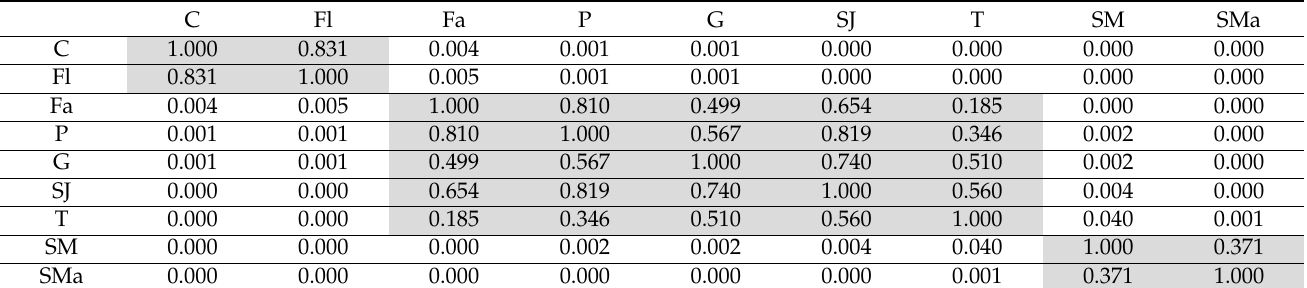
Table 5. Correlation matrix of the ISAR model with a Gaussian process for the Canary Islands (median values). The grey shading areas highlight the two major groups of islands: the western and eastern groups. The abbreviations mean: F—Fuerteventura, L—Lanzarote, GC—Gran